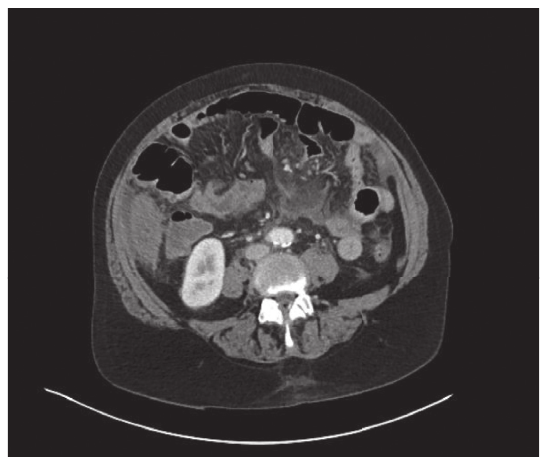
Figure 1: Initial computed tomography (CT) of the abdomen and pelvis with small bowel enteritis and fluid collections in paracolic gutters.